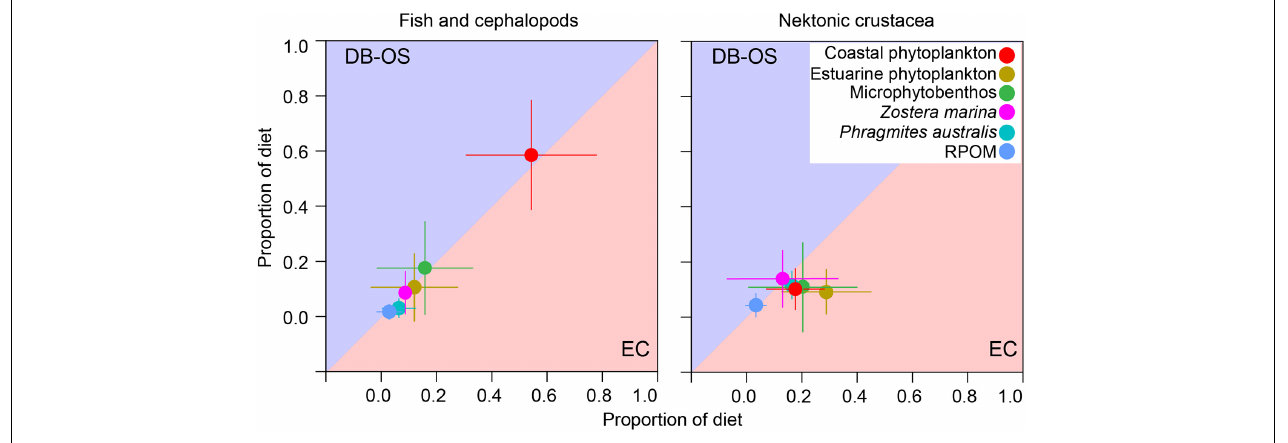
FIGURE 7 | Comparison of estimated trophic contributions (mean ± 1SD) of putative primary organic matter sources to nektonic consumers of the estuarine channel (EC) and coastal (DB/OS) sites, indicating higher trophic connectivity in the highly mobile fish and cephalopods than that of nektonic